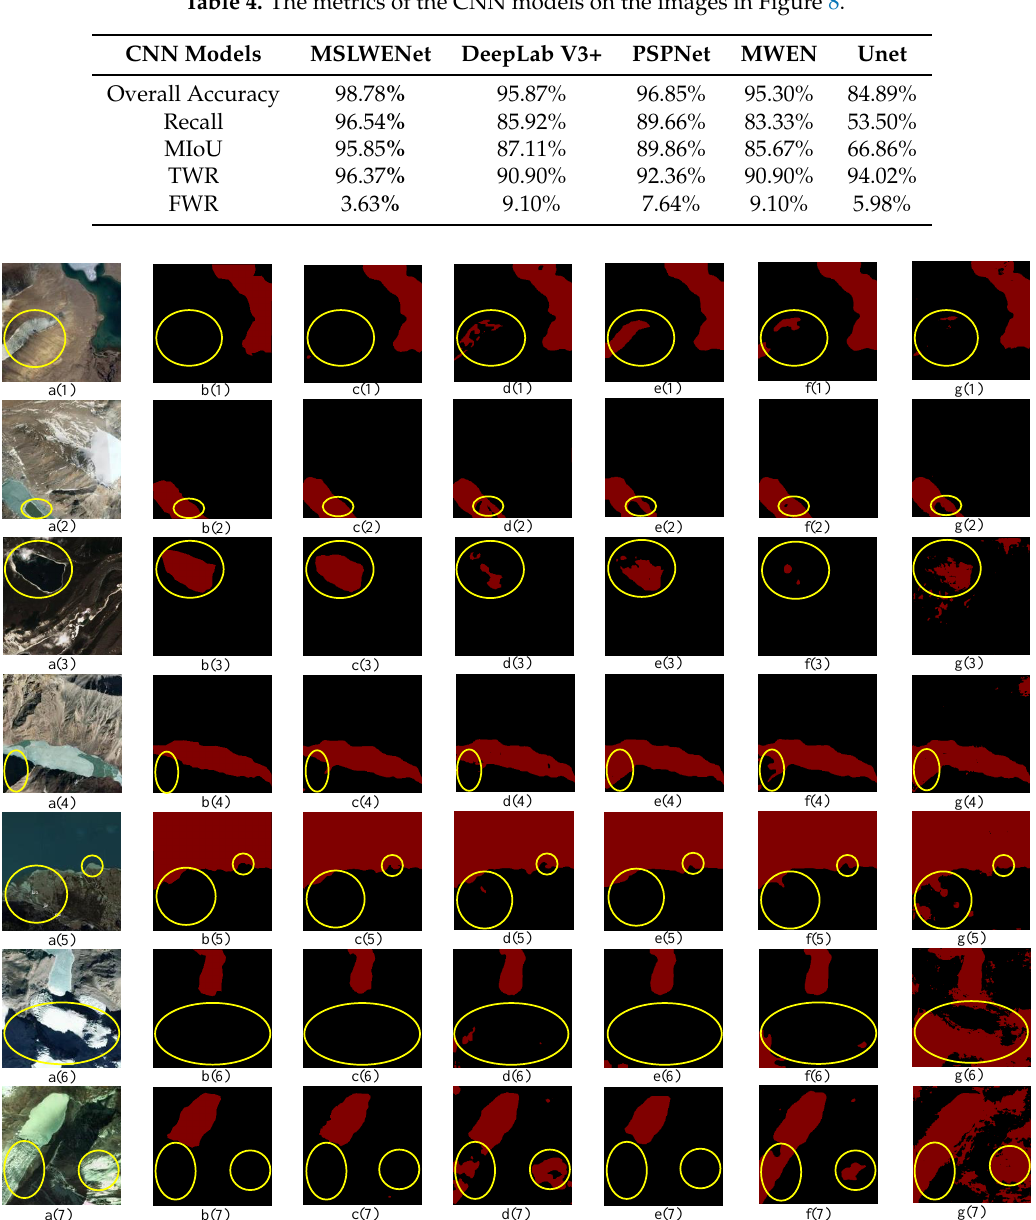
Table 4. The metrics of the CNN models on the images in Figure 8.